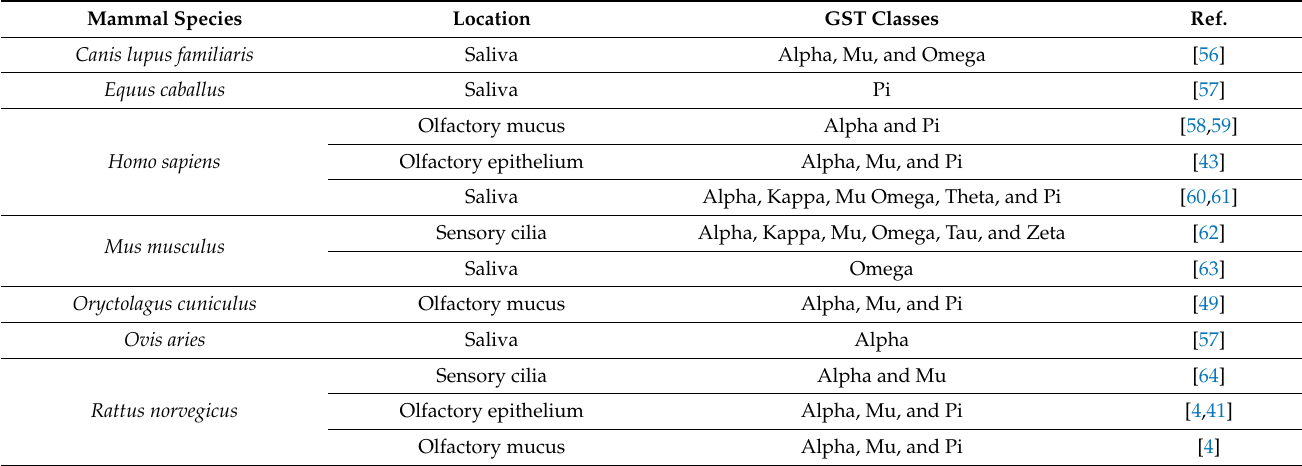
Table 1. Location and classes of GSTs within the mammal’s chemosensory